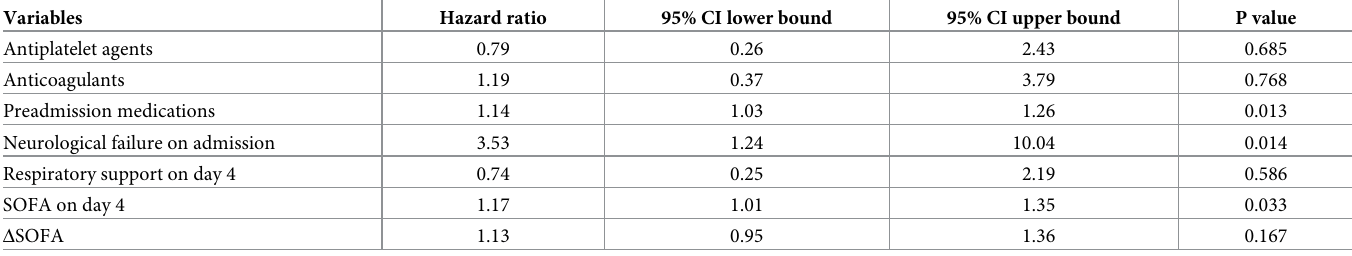
Table 2. Multivariate Cox model of mortality on day 90 including SOFA scores adjusted for imputed and independent covariates (primary analysis with 87 patients). The change in the SOFA score ( Δ SOFA) was calculated as SOFA score on day 1 –SOFA score on day